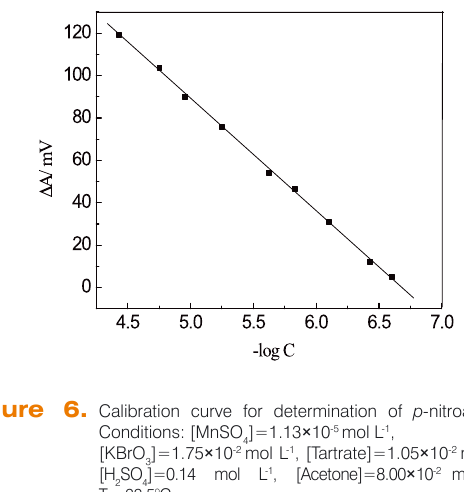
Figure 6. Calibration curve for determination of p- nitroaniline. ]=1.13 × 10 -5 mol L -1 , ]=1.13 × 10 -5 mol L -1 , Conditions: [MnSO 4 4 [KBrO ]=1.75 × 10 -2 mol L -1 , [Tartrate]=1.05 × 10 -2 mol L -1 , 3